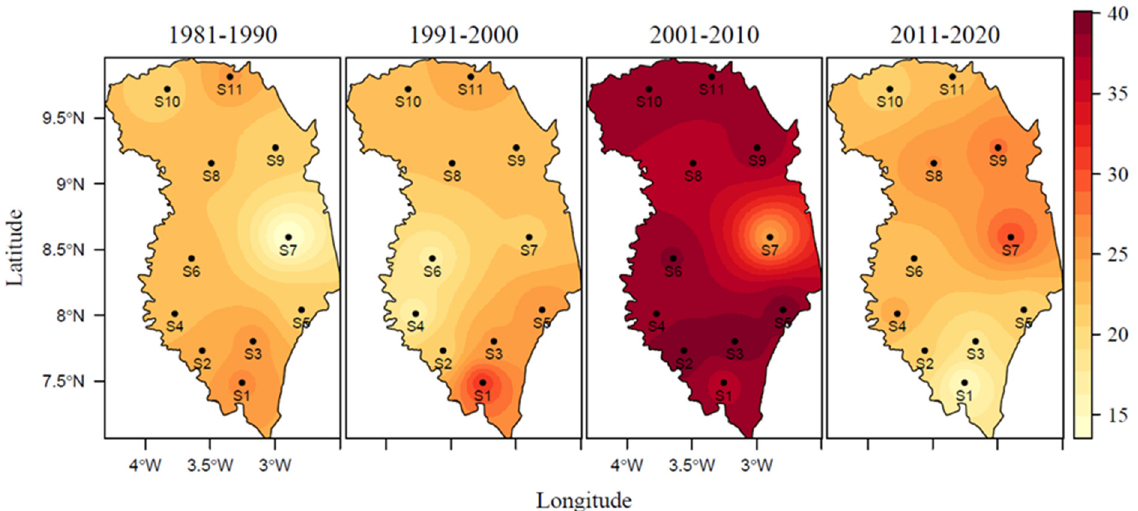
Figure 13. Spatial distribution of warm spell duration indicator (WSDI) (days) per decade in Zanzan region. Stations (S1 = Koun Fao, S2 = Kouassi-datékro, S3 = Tanda, S4 = Sandegué, S5 = Bondoukou, S6 = Nassian, S7 = Sapli, S8 = PN Comoé S1, S9 = Bouna, S10 = Téhini, S11 = Doropo).